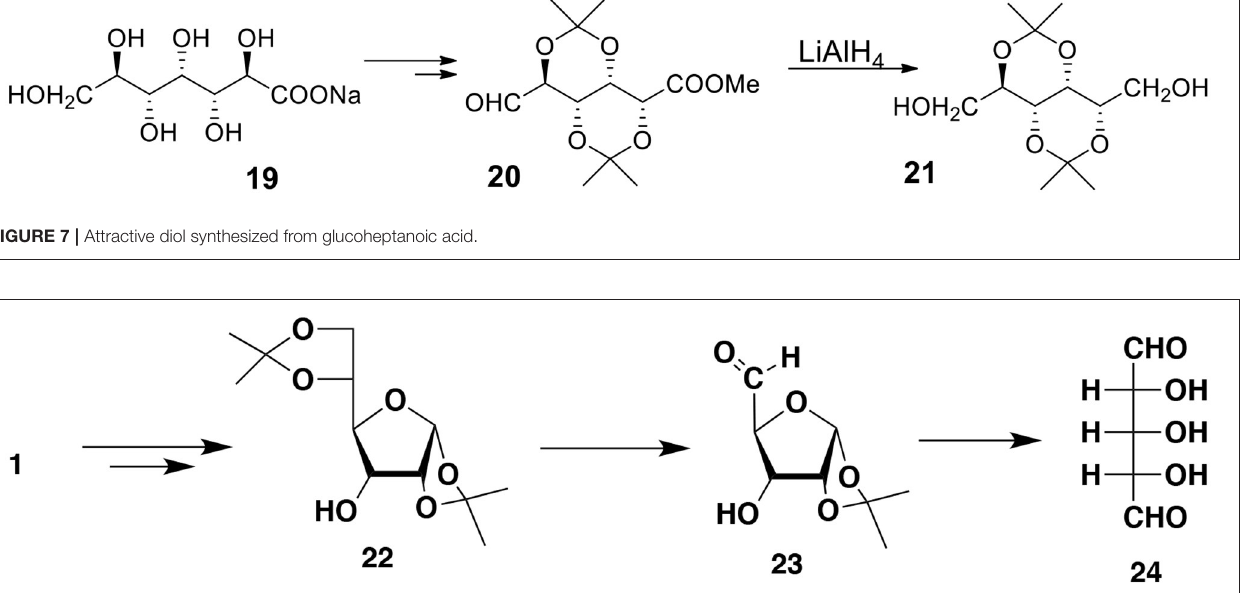
FIGURE 8 | Miculka’s synthesis of trihydroxydialdehyde 24